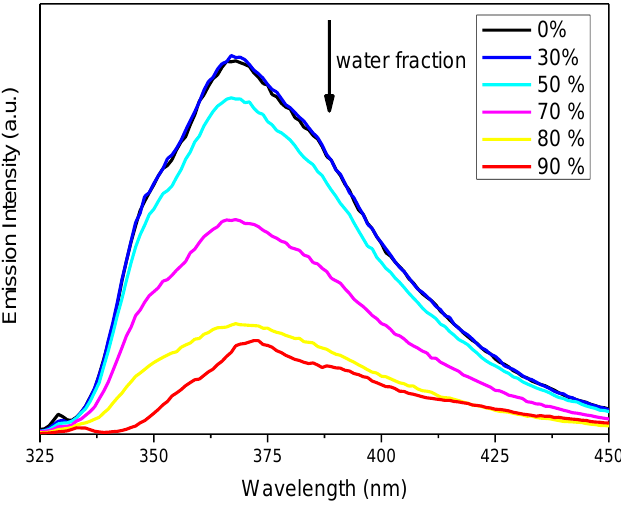
Figure 3. PL emission spectra of TT-HThio in THF with increasing water fractions; λ exc = 300 nm. The relation between the photophysical properties of the sample and its crystallinity degree has been confirmed by a decrease in Φ (18%) and the loss of vibronic components when TT-HThio crystals are ground in a mortar, revealing mechanochromic behavior and confirming CEE features (Figure 4).